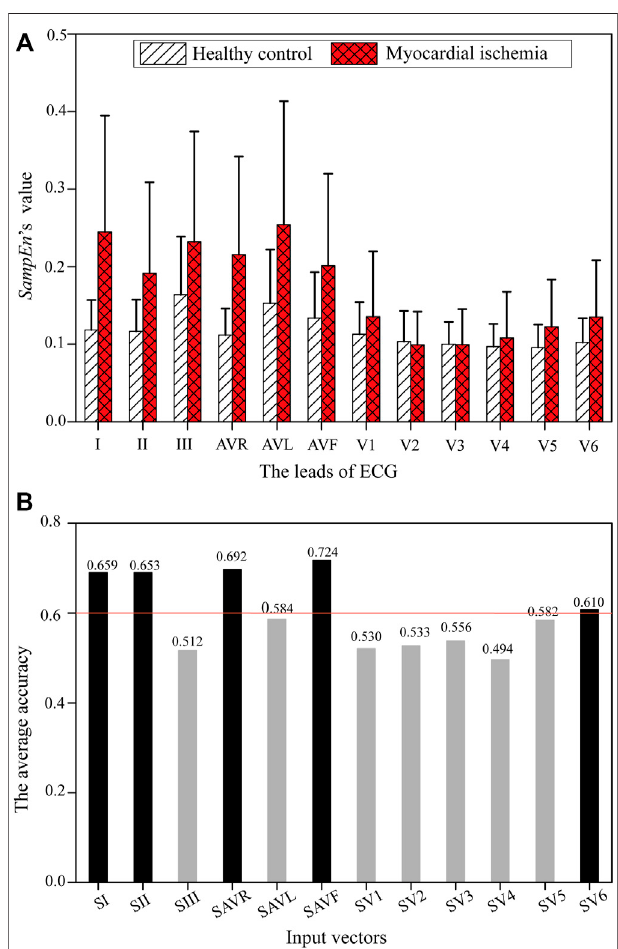
FIGURE 5 | SampEn of each ECG lead from healthy controls and patients with myocardial ischemia. (A) SampEn of each ECG lead. (B) The average accuracy of an ECG-only model using each single Si on the training dataset.